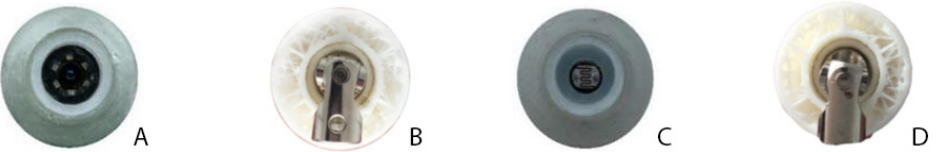
Figure 6. Light sensor and FEA camera implementation into the robotic eye: ( A ) RGB camera for the FEA application; ( B ) ball and socket joint; ( C ) photo-resistor sensor to measure light; ( D ) flexible mount for the ball and socket joint.